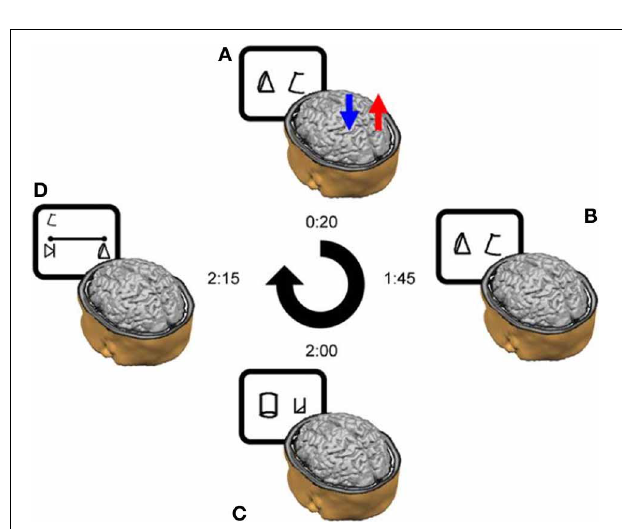
FIGURE 2 | Schematic outline of the experimental design in a typical daily session. (A) tDCS was delivered for 20min from the start of the training. In this example, anodal stimulation is applied to the right parietal lobe (red arrow), whereas cathodal stimulation is delivered to the left parietal lobe (blue arrow). (B) The training continued after the termination of the stimulation. (C) Once the training ended, the subjects performed the numerical Stroop task and (D) the number line task. The time next to each image reflects the elapsed time from the beginning of the daily session until its termination in a cumulative fashion. Please note that on Day 1 only, the session ended after the learning phase—thereby it did not include the experimental tasks (i.e., Stroop-task and number line task). Reprinted from Cohen Kadosh et al. (2010), with permission from